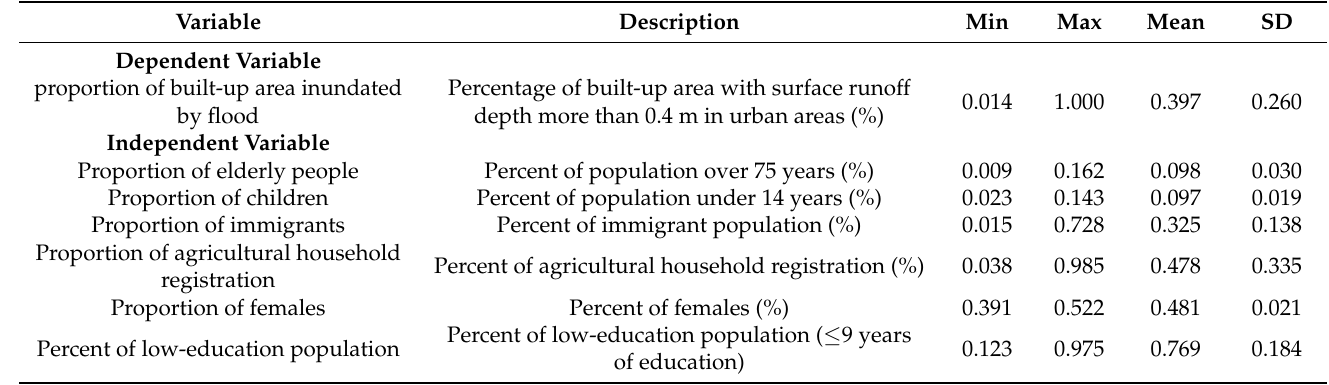
Table 1. Variable definitions and summary statistics for variables used in Nanjing,